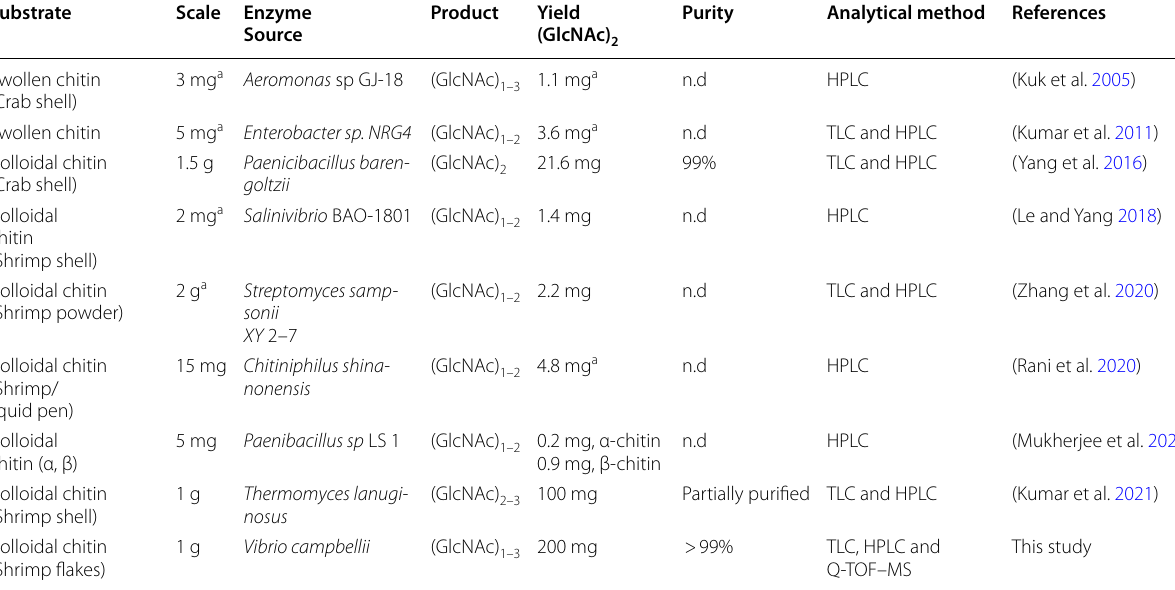
a Weight is converted from the concentration (% or mM) and reaction volume given in each report